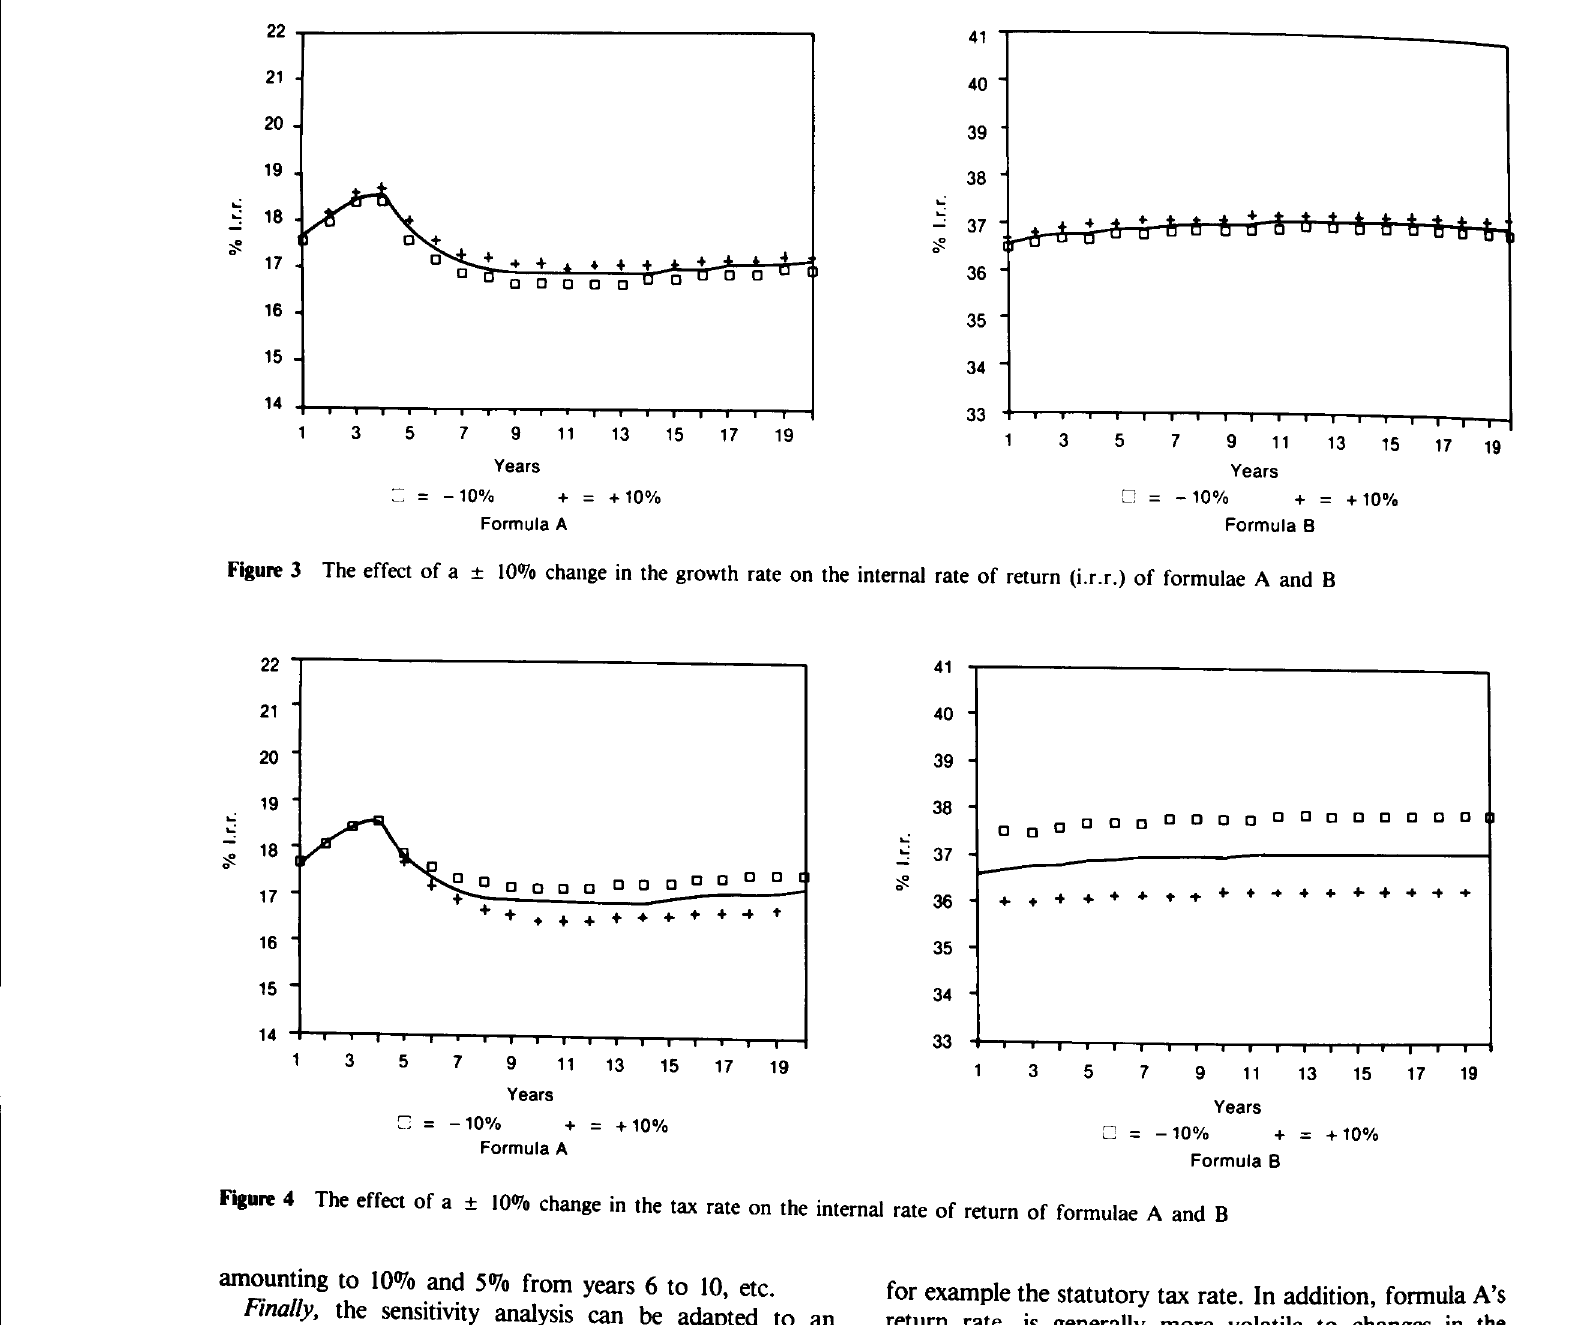
Figure 3 The effect of a ± 10% change in the growth rate on the internal rate of return (i.r.r.) of formulae A and B